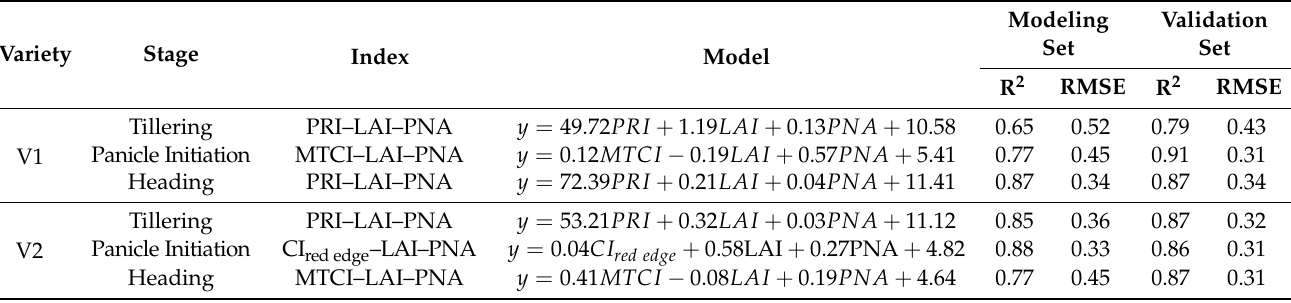
Table A2. Three-factor multiple linear regression rice grain protein content (GPC) estimation models and their accuracy ( n = 15).